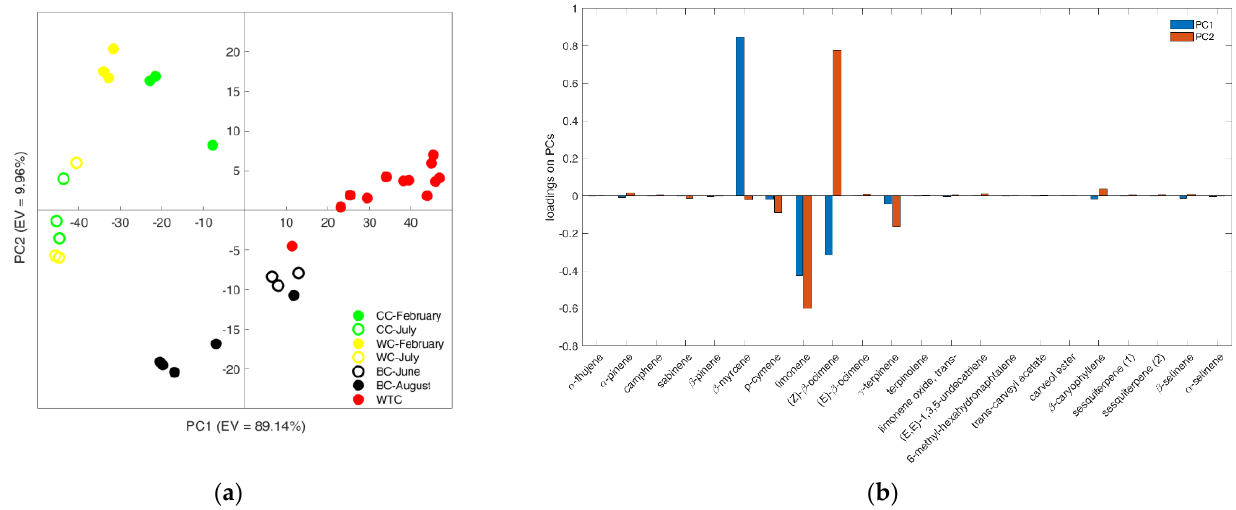
Figure 3. PCA on the volatile profiles of celery leaves after data centering: ( a ) projection of the samples on the PC1-PC2 plane; ( b ) variable loadings.